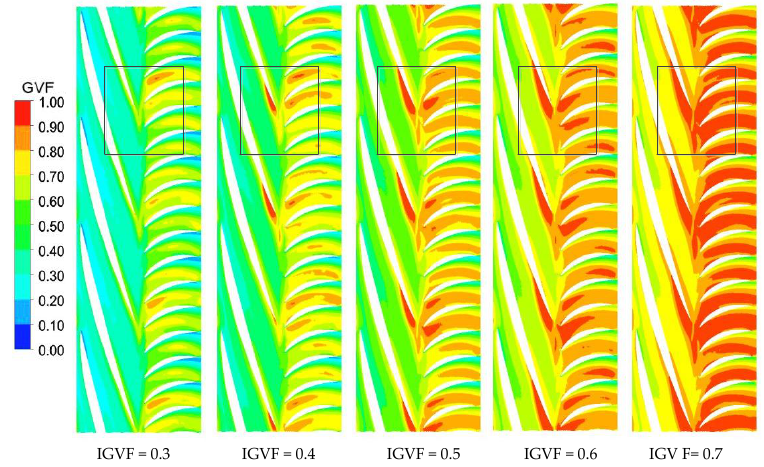
Figure 7. Distribution of gas at 10% of the blade height with different inlet gas volume fractions (IGVFs) under the design working conditions.